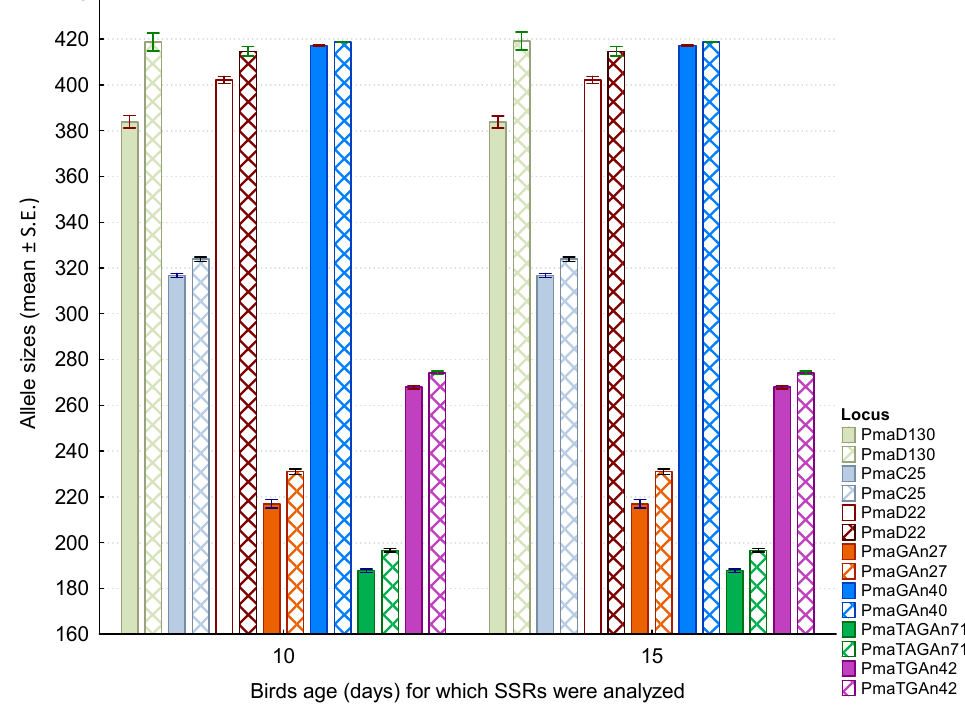
Figure 4. Allele sizes (mean ± S.E.) recorded for SSRs genotyped twice in 5-day interval for nestlings, which were assigned to the control group.